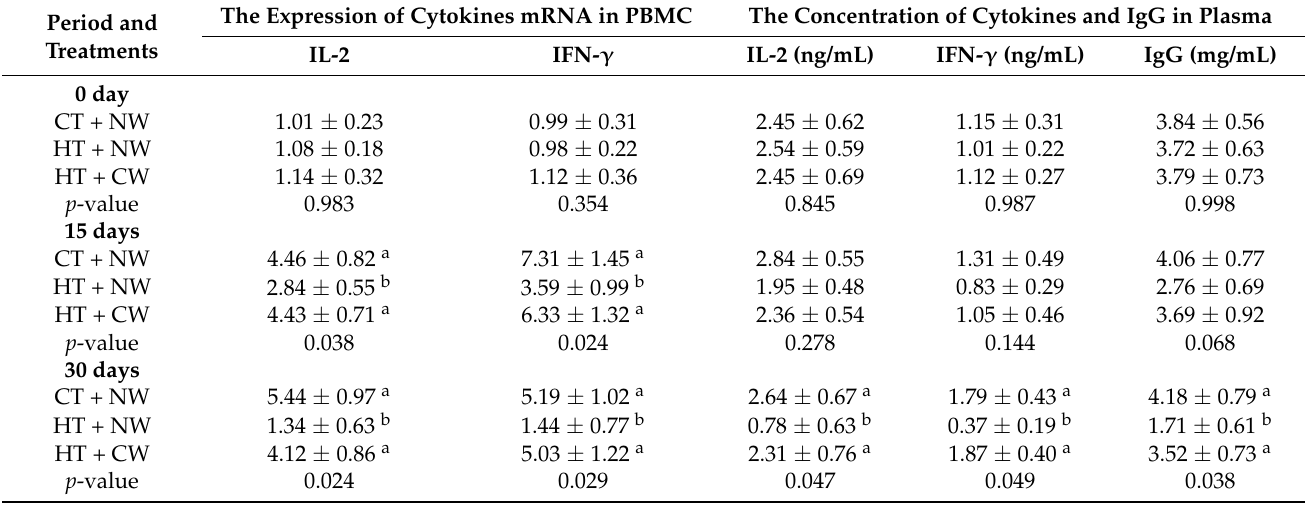
Table 5. Effects of cold drinking water on the mRNA expression of cytokines in PBMC and immune parameter concentration in plasma of laying hens after heat stress